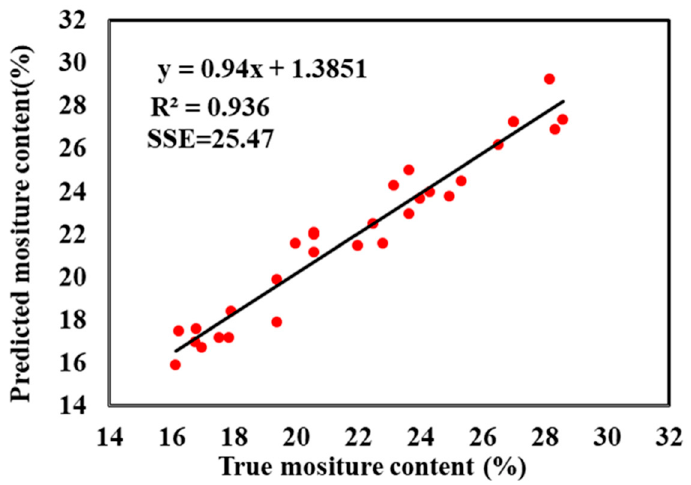
Figure 9. The linear fitting result between the detected moisture content and the true content.